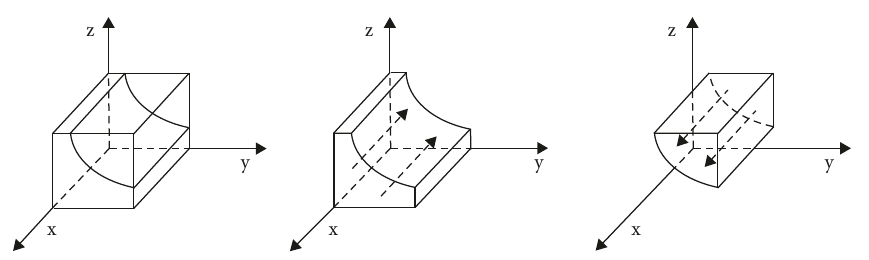
Figure 1: Dynamic replication phase diagram of the evolution of the local government’s strategic